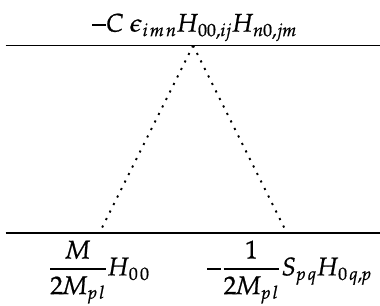
JHEP03(2023)019